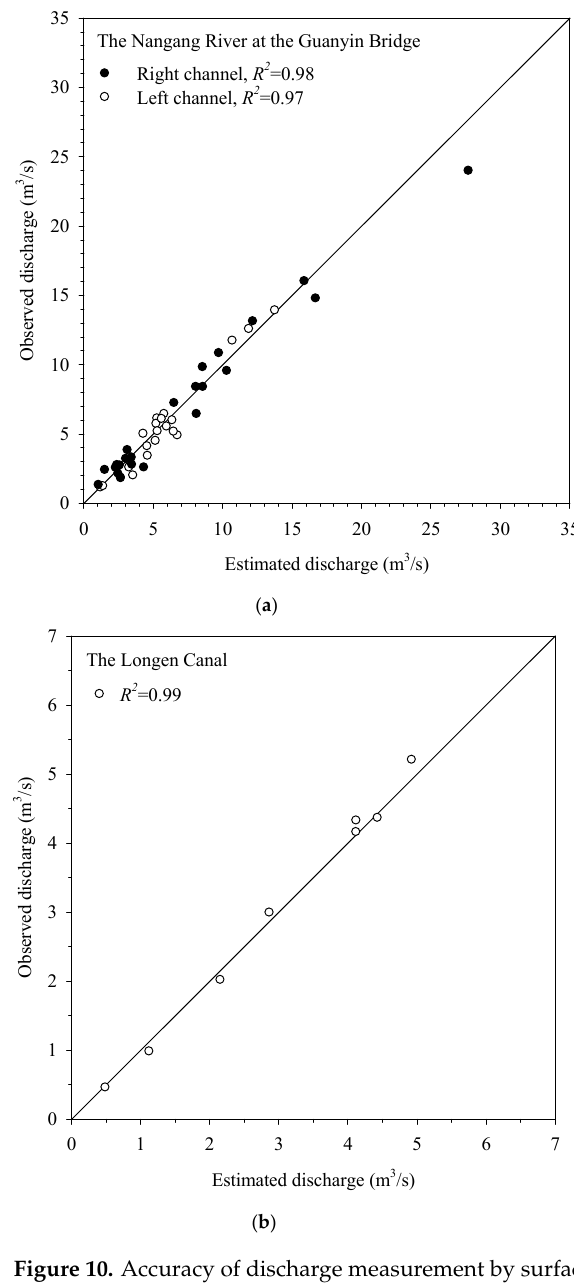
Figure 10. Accuracy of discharge measurement by surface mean velocity; ( a ) the Nankang River at the Guanyin Bridge; ( b ) the Longen Channel.